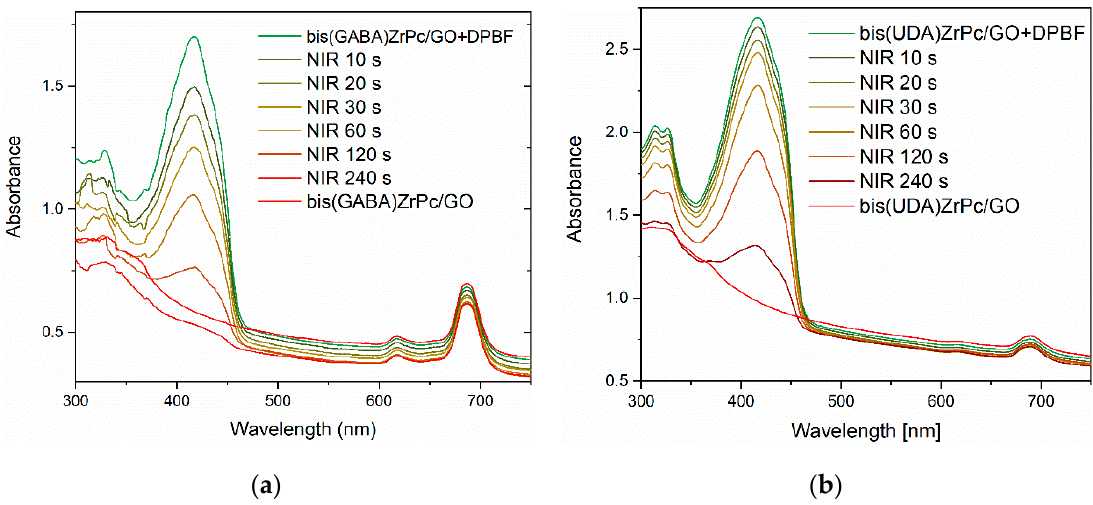
Figure 2. Absorption spectra of ( a ) bis(4-aminobutyrato)ZrPc/GO and ( b ) bis(11-aminoundecannato)ZrPc/GO suspensions in DMSO and after addition of 1,3-diphenylisobenzofuran, showing DPBF bleaching caused by singlet oxygen generation with increasing time of irradiation. Raman scattering spectra of both ZrPcs showed that the bands originated from macrocyclic rings and ligand chain vibrations (Figure 3a). These peaks were not recorded in the case of ZrPc/GO samples, where only D and G bands of graphite oxide were seen.